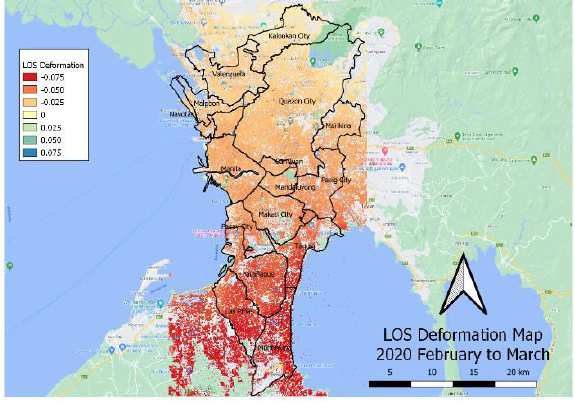
Figure 14. LOS Deformation (February 2020 – March